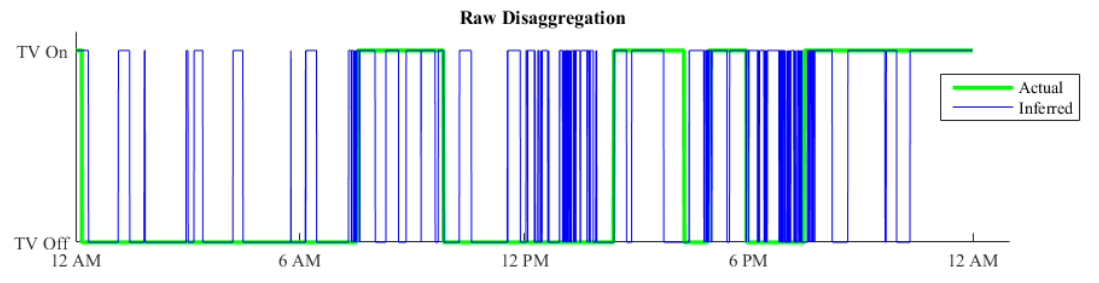
Figure 11. Disaggregation of TV 1 from house